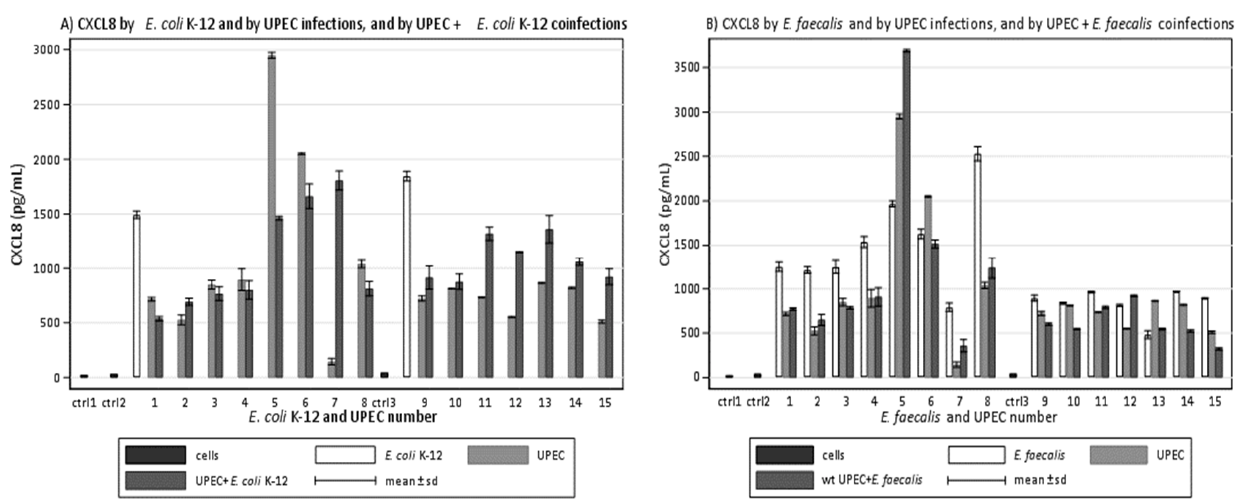
Figure 1. Amounts (pg/mL) of CXCL8 induced in 5637 bladder epithelial cell line by fifteen UPEC: ( A ) CXCL8 induced by UPEC strains and by UPEC strains plus the common E. coli K-12 compared to CXCL8 induced by the common E. coli K-12 alone; ( B ) CXCL8 induced by UPEC strains and by UPEC strains plus E. faecalis isolated from the same urine compared to CXCL8 induced by E. faecalis alone.